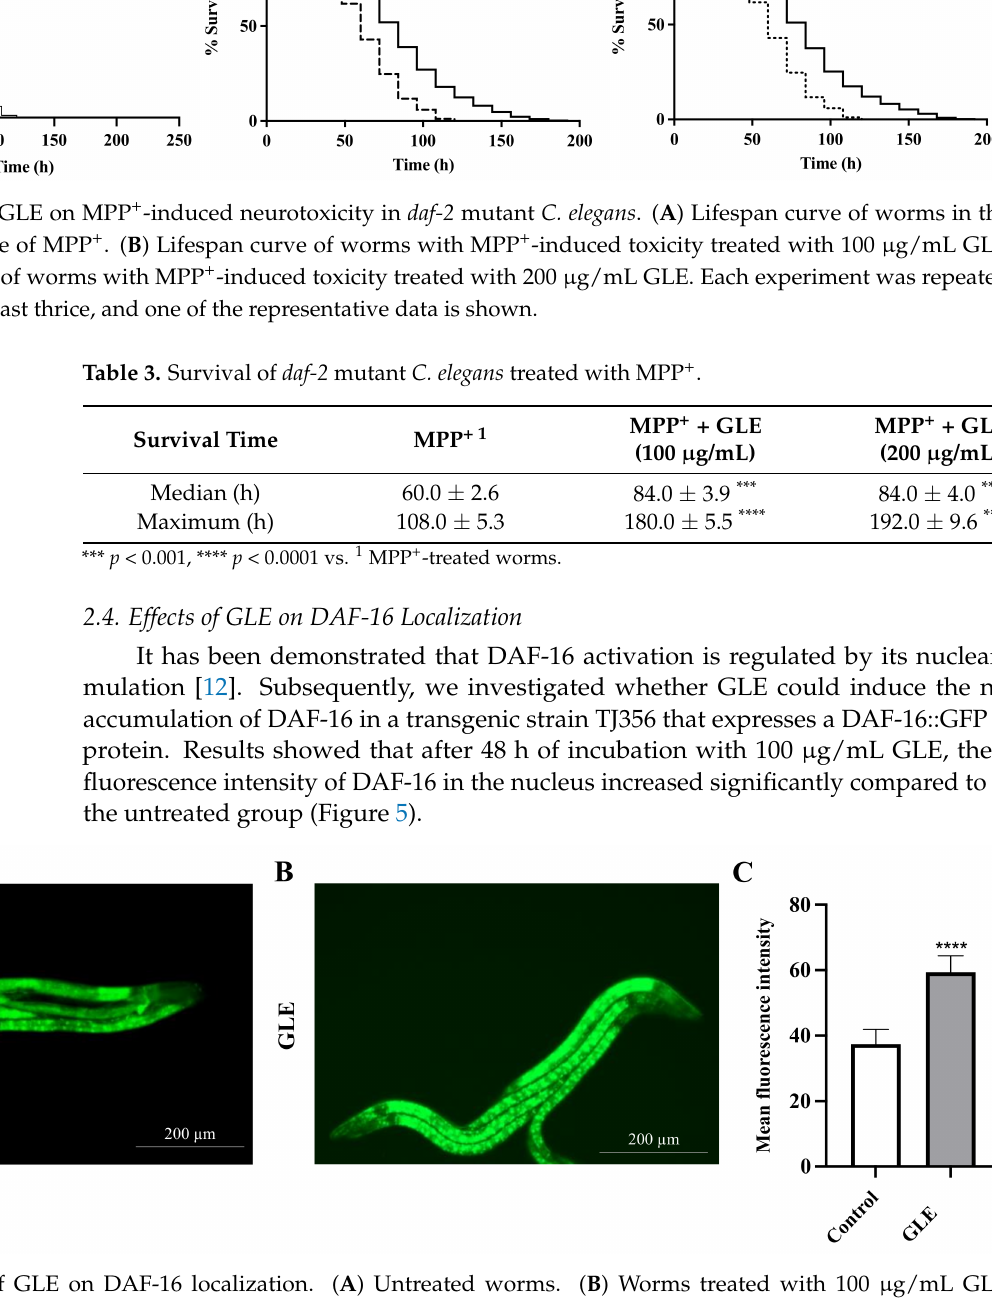
Figure 5. Effect of GLE on DAF-16 localization. ( A ) Untreated worms. ( B ) Worms treated with 100 µ g/mL GLE. ( C ) Quantification of DAF-16::GFP nuclear accumulation in GLE and GLE-free conditions. The scale bar shows 200 µ m. Each experiment was repeated independently at least thrice. Significant differences were analyzed using the t -test method; **** p < 0.0001 as compared with